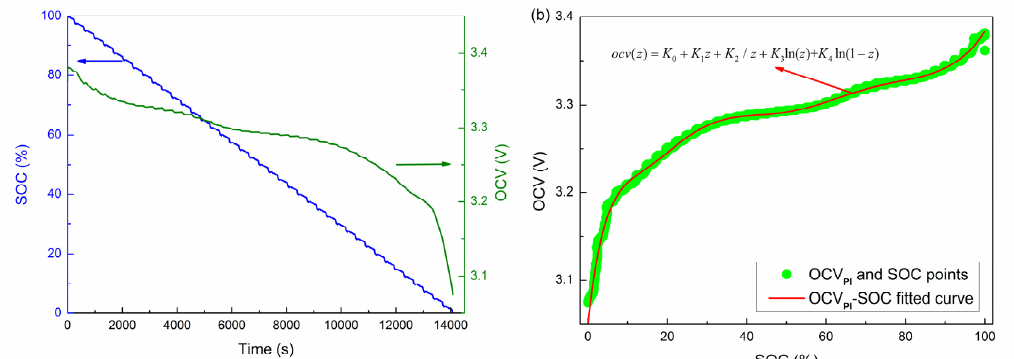
Figure 22. Establishing OCV PI -SOC relationship in the DST test at 40 °C: ( a ) online identification of the OCV and the true SOC and ( b ) the scatter plot and fitted curve of OCV PI and the true SOC.